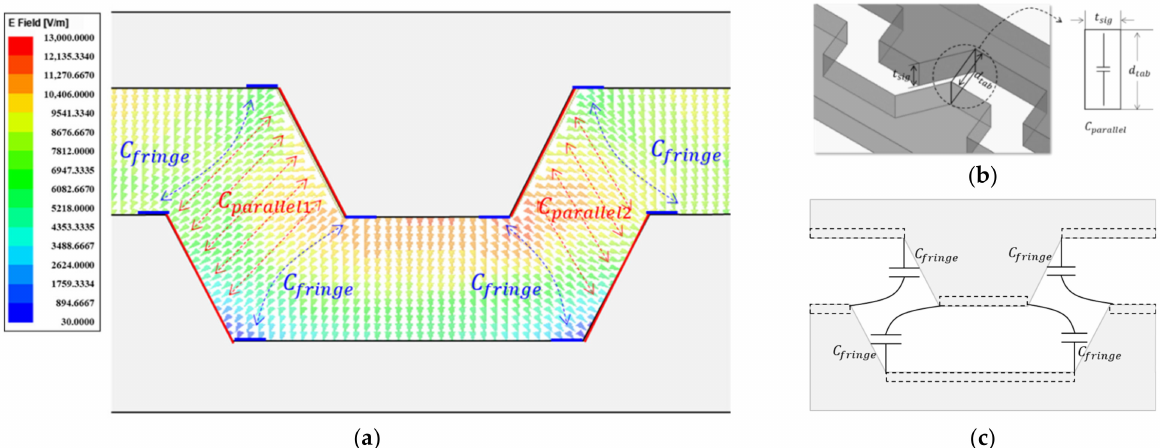
Figure 6. ( a ) Simulation result of E-field vector shown with tabbed routing. In contrast to the micro-strip line without a tab, in which an E-field in one direction is formed, for tabbed routing, an oblique E–field can be seen between the oblique tabs and fringing E-field at the top of the Table ( b ) The oblique tab is coupled with an adjacent oblique tab; the tabs are considered as parallel plates. ( c ) The edge of the tab has a fringing effect on the coupled line between